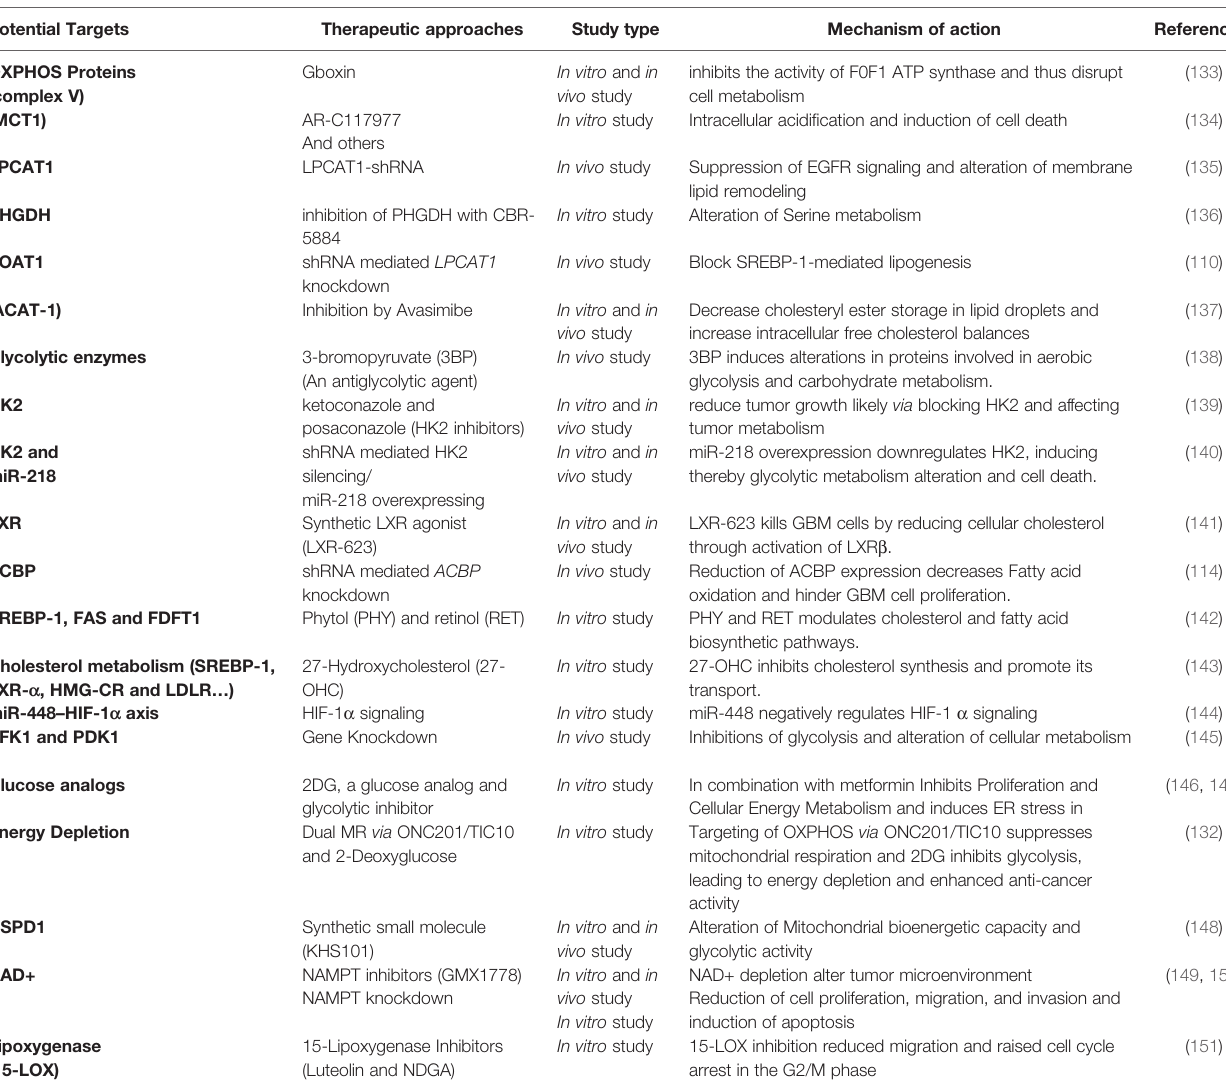
TABLE 2 | Potential targets and promising agents against glioblastoma